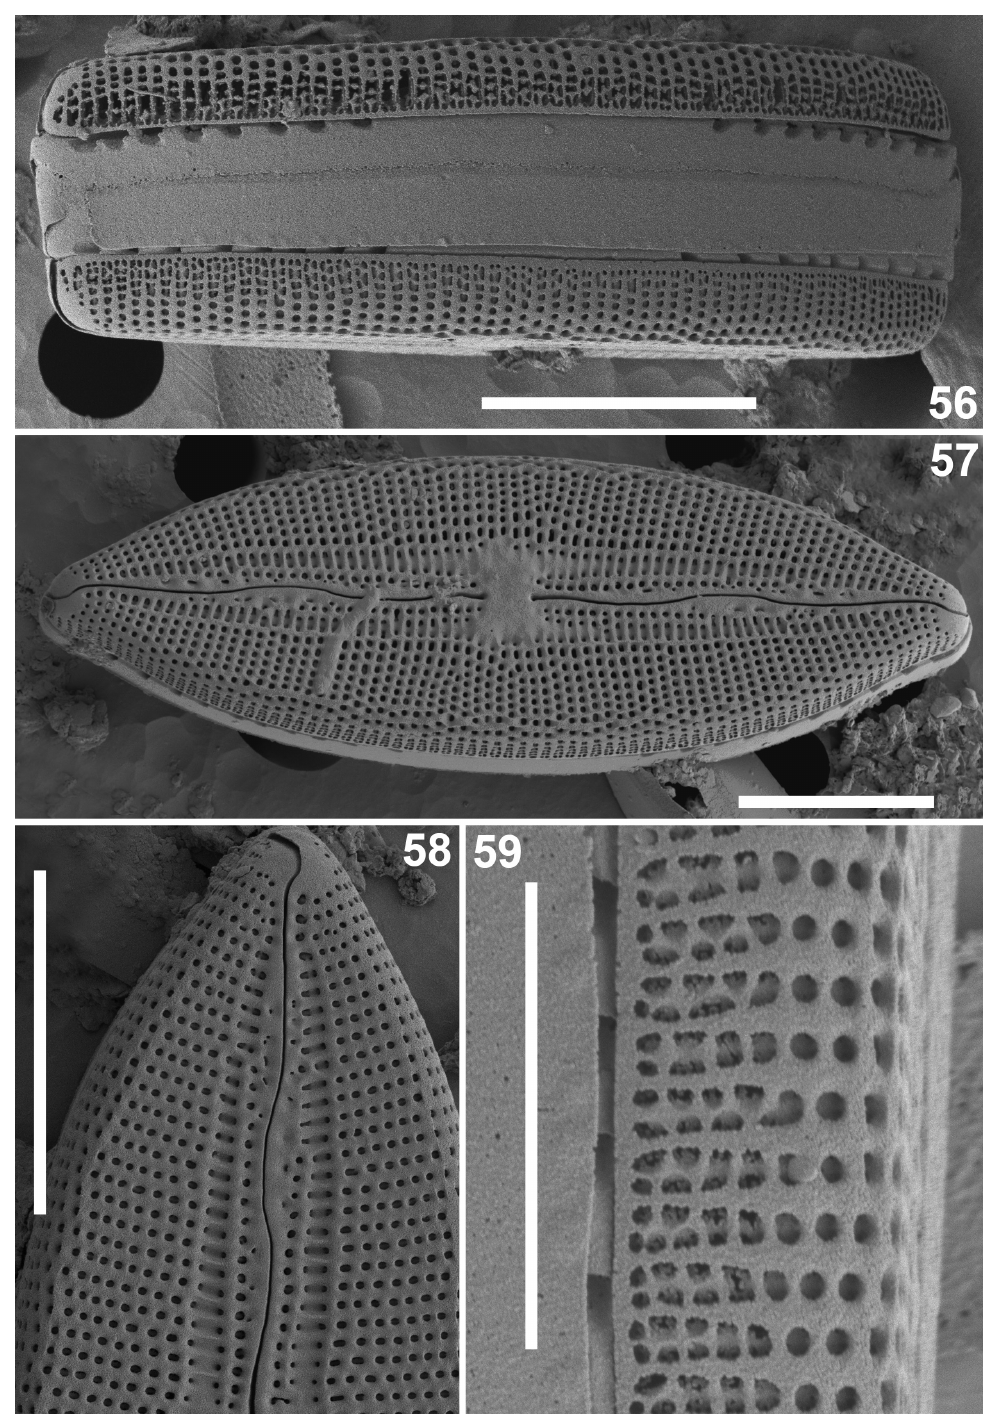
Figs 56–59. Mastogloia senegalensis Van de Vijver, Fofana, Sow & Ector sp. nov. Scanning electron micrographs (SEM) of valves from the Lac de Guiers type population ( Van de Vijver sample SEN-42 ). 56 . SEM girdle view of an entire frustule showing the partectal pores and the mantle areolae. 57 . SEM external view of an entire valve with typical undulating raphe branches. 58 . SEM external detail of the apex and the axial area with the depressed grooved on both sides of the raphe. 59 . SEM external detail of the valve mantle. Scale bars: 10